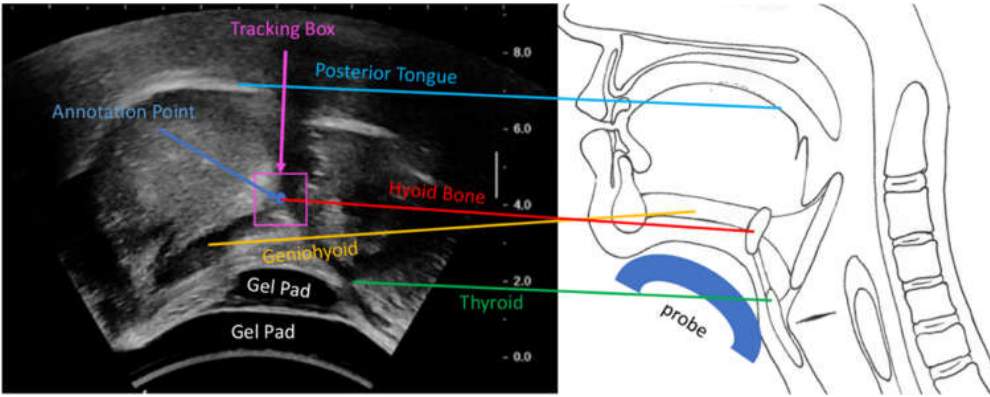
Figure 1. The left side of the figure shows an example ultrasound image with labeled anatomical structures, as illustrated on the right side. The hyoid bone annotation point was placed at the in- on the right side. The hyoid bone annotation point was placed at the intersection of the geniohyoid muscle (left) and the tersection of the geniohyoid muscle (left) and the acoustic shadow (above). During inference, a acoustic shadow (above). During inference, a bounding box tracked the hyoid bone bounding box tracked the hyoid bone location.